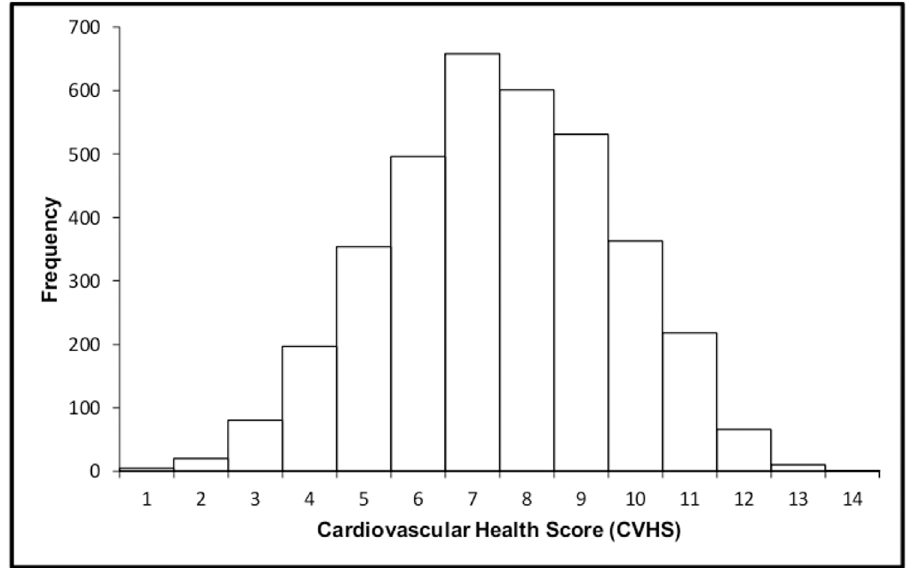
Fig 1. The distribution of Cardiovascular Health Score in survey participants. Smoking status (current, former, or never smokers) was derived from interviews. Physical activity as described previously [18] was self-reported. Those who participated in physical activity four times or more a week for at least 30 minutes were categorized as physically active, those who exercised less than four times a week but at least 2 – 3 times a month were categorized as moderately active and those who exercised several times a year or did not exercise at all were categorized as physically